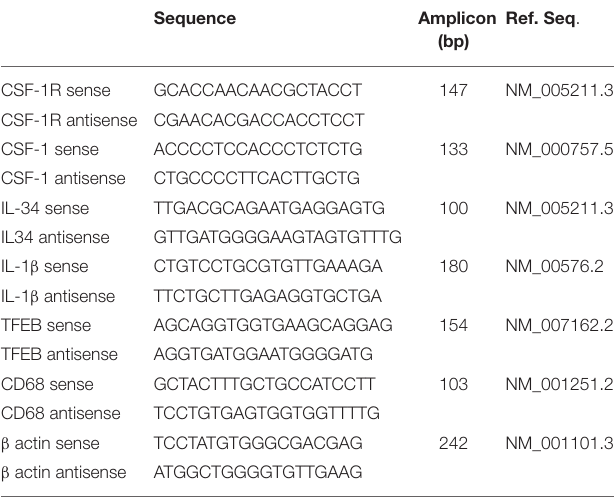
TABLE 2 | PCR primer